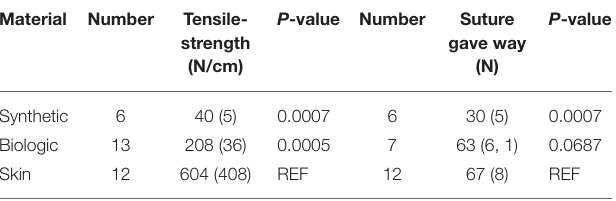
TABLE 2 | Comparison between the different